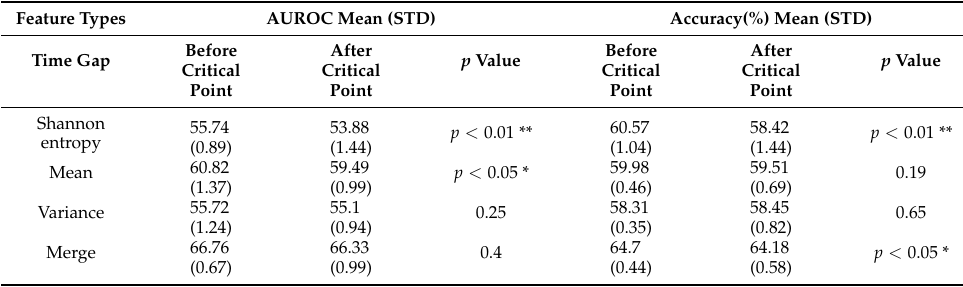
Table 10. Comparison between using a time gap of less than 30 h (rapid AKI oscillation) and a time gap greater than 30 h (slight AKI signs) on Recall, and